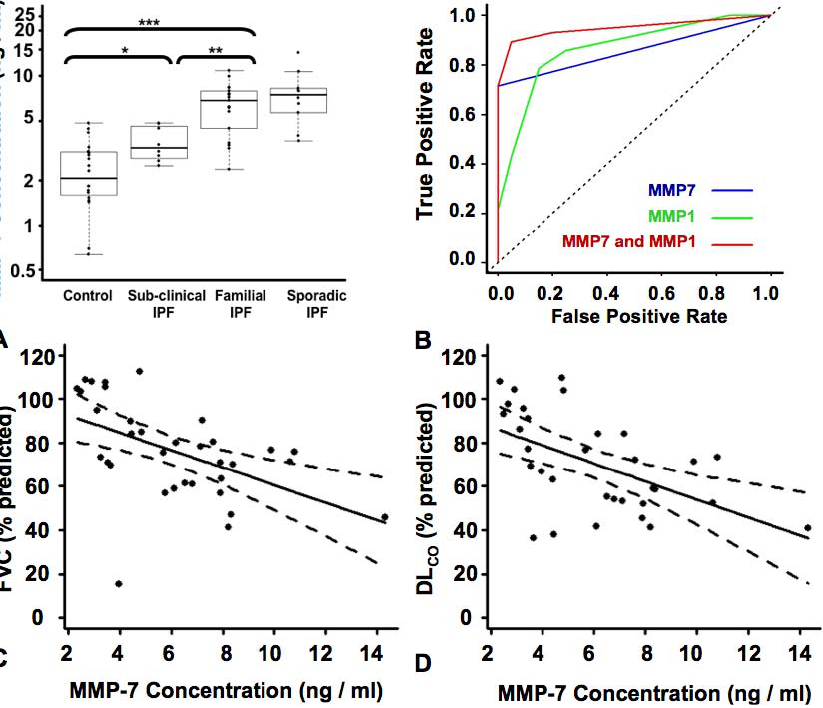
Figure 5. MMP7 Concentrations Significantly Distinguish Control from Subclinical ILD, Familial, or Sporadic IPF (A) Dark solid lines show median concentrations in each group. The interquartile range (IR) or middle 50% of concentrations is delimited by a box. Data are expressed on a log base 2 scale. (B) ROC curves for using MMP1 or MMP7, or their combination, to classify samples as IPF (sporadic or familial) or control in validation cohort. (C and D) Serum MMP7 concentrations moderately correlate with decreases in FVC% (C) and DL CO % (D). Linear regressions and 95% CI inversely relate MMP7 concentration (ng/ml) to FVC% and DLCO%. * p , 0.05, ** p , 0.01, and *** p , 0.001.